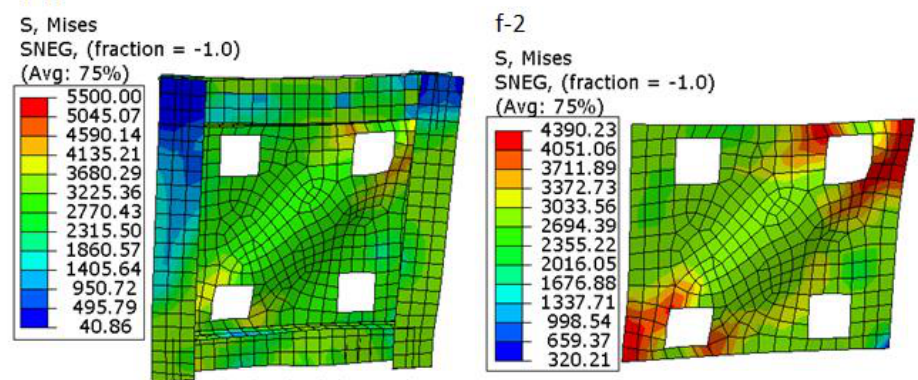
Figure 18. Von Mises stress for shell part ( f-1 ) frame part and ( f-2 ) steel plate.